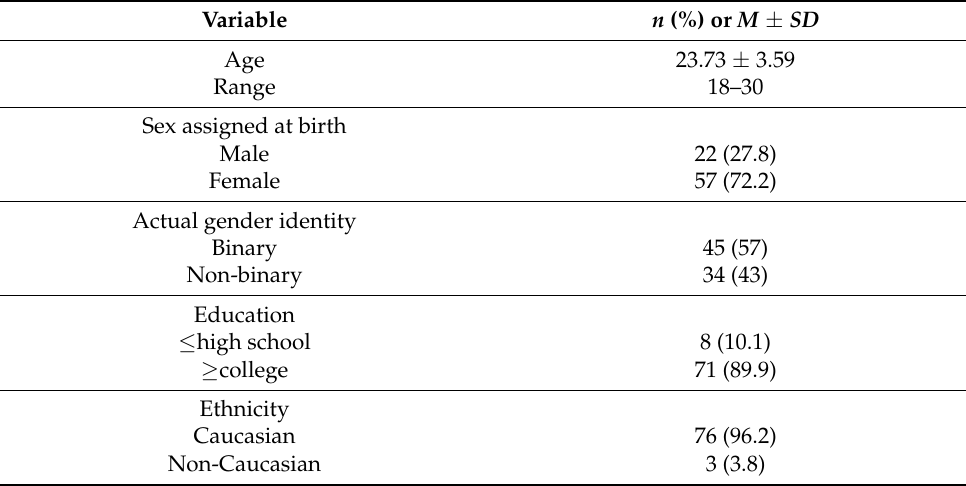
Table 1. Socio-demographic characteristics of participants ( N = 79).